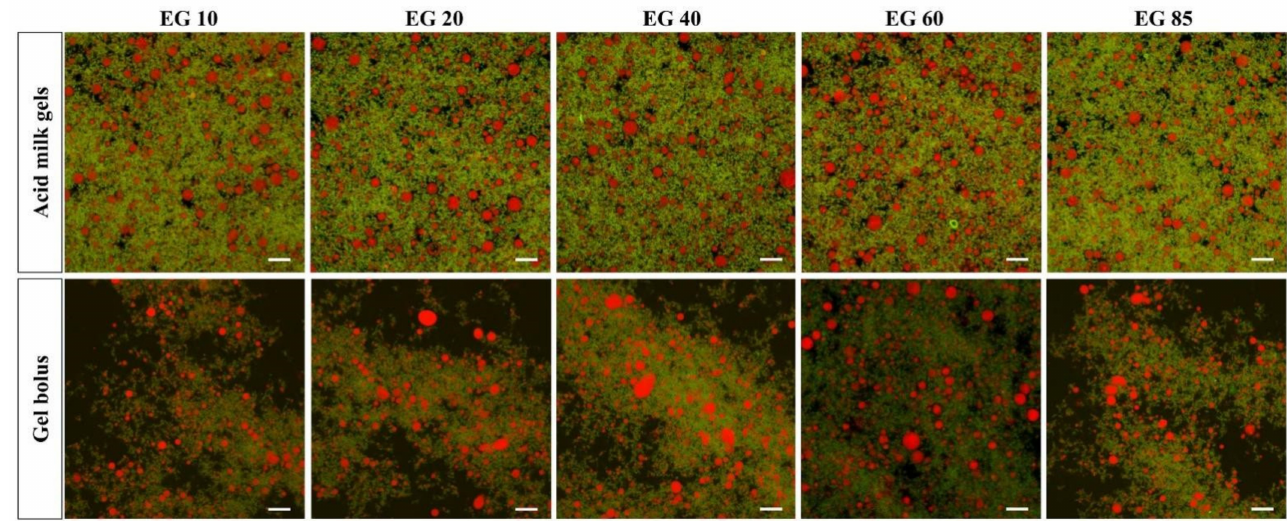
Figure 4. Microstructure of acid milk gels before and after simulated oral processing. Red: fat globules; green: protein; scale bar 15 µ